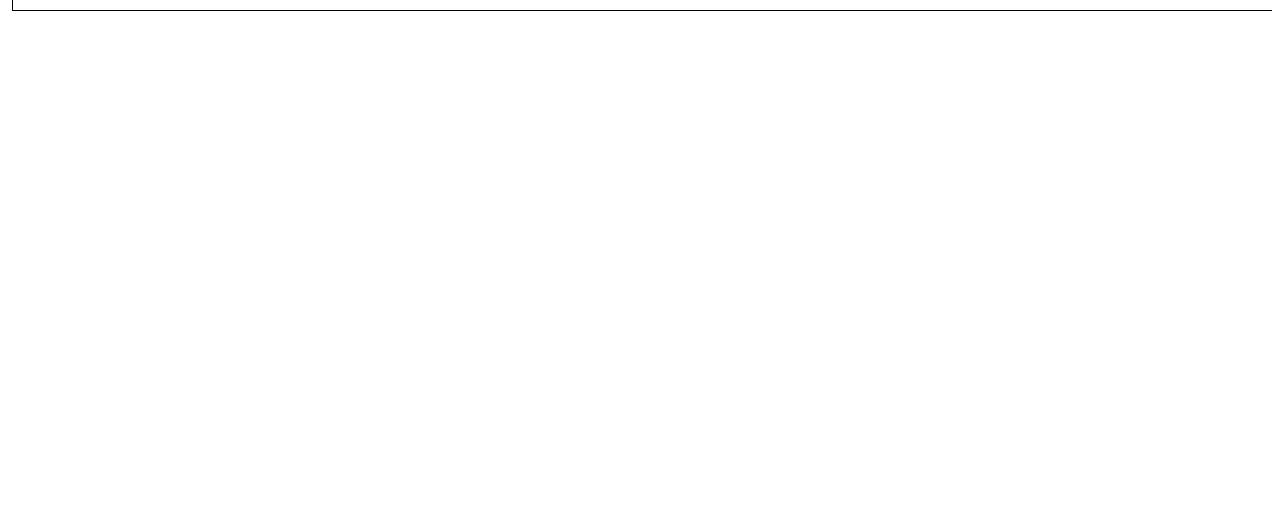
FIGUREA3 | LBA model fit for Participant